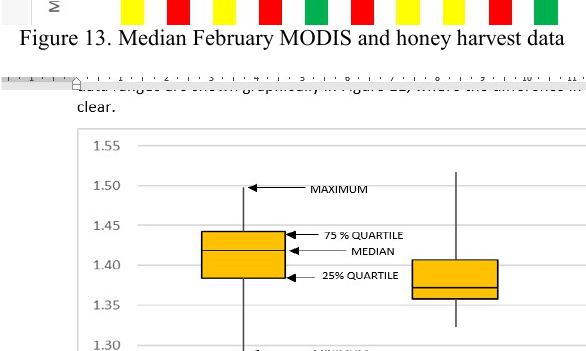
Figure 14. February median band 10/8 ratio data ranges for good to poor